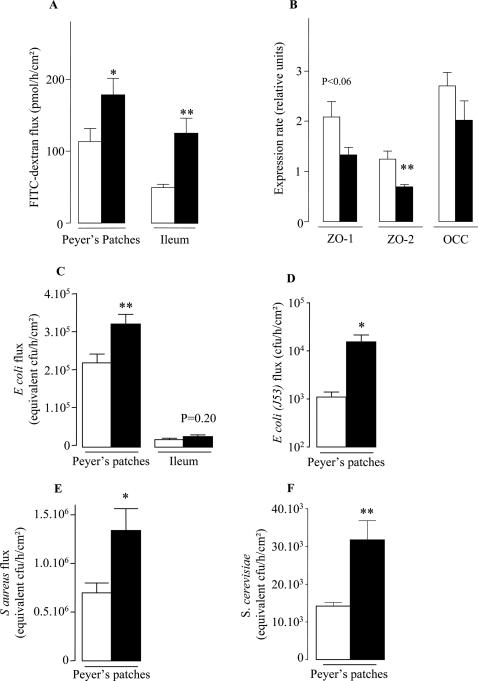
Paracellular permeability and bacterial translocation are increased in Nod2 invalidated mice.Ussing-chamber and Real-time PCR experiments were performed on PP and PP-free ileum from WT (□) and KO (▪) at week 12. (A) Paracellular permeability was analysed by FITC-dextran flux from PP and PP-free ileum under basal condition. (B) mRNA expression levels of TJ proteins (ZO-1, ZO-2 and Occ) from PP were analysed by real-Time-PCR under basal condition. (C) Bacterial translocation of chemically killed fluorescent Escherichia Coli K-12. (D) Translocation of the viable non enteropathogen Escherichia Coli strain J53. (E) Translocation of a chemically killed fluorescent Staphylococcus Aureus. (F) Translocation of chemically killed fluorescein-conjugated Saccharomyces cerevisiae. Data represent the means±SEM of 8 mice per group. *P<0.05 and **P<0.01, significantly different from WT.